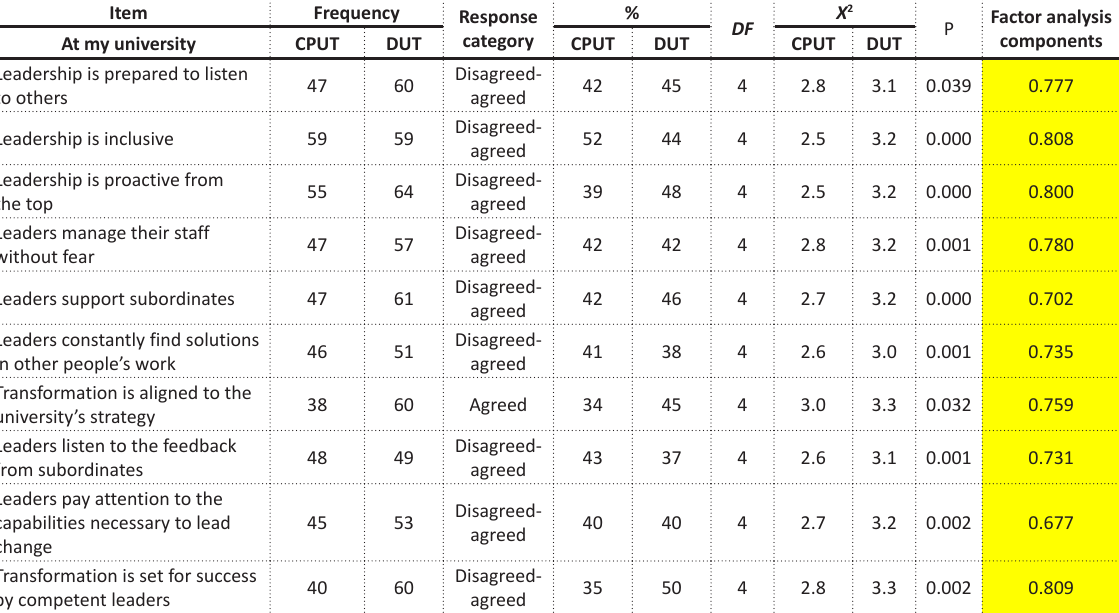
Table 6. Leadership qualities achieving the transformation